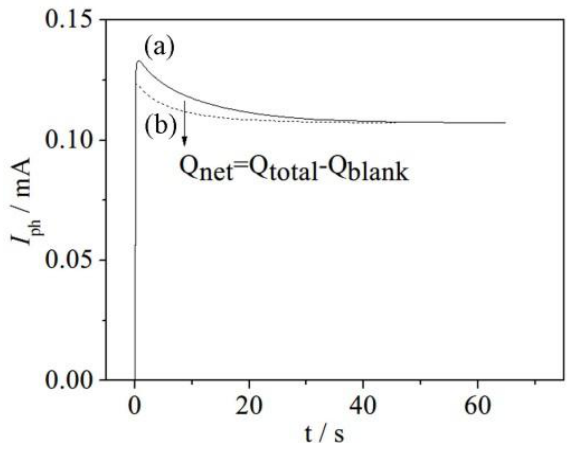
Figure 2. Typical photocurrent responses of sample containing organics: ( a ) and none organics; ( b ) under illumination of visible light at 420 nm.